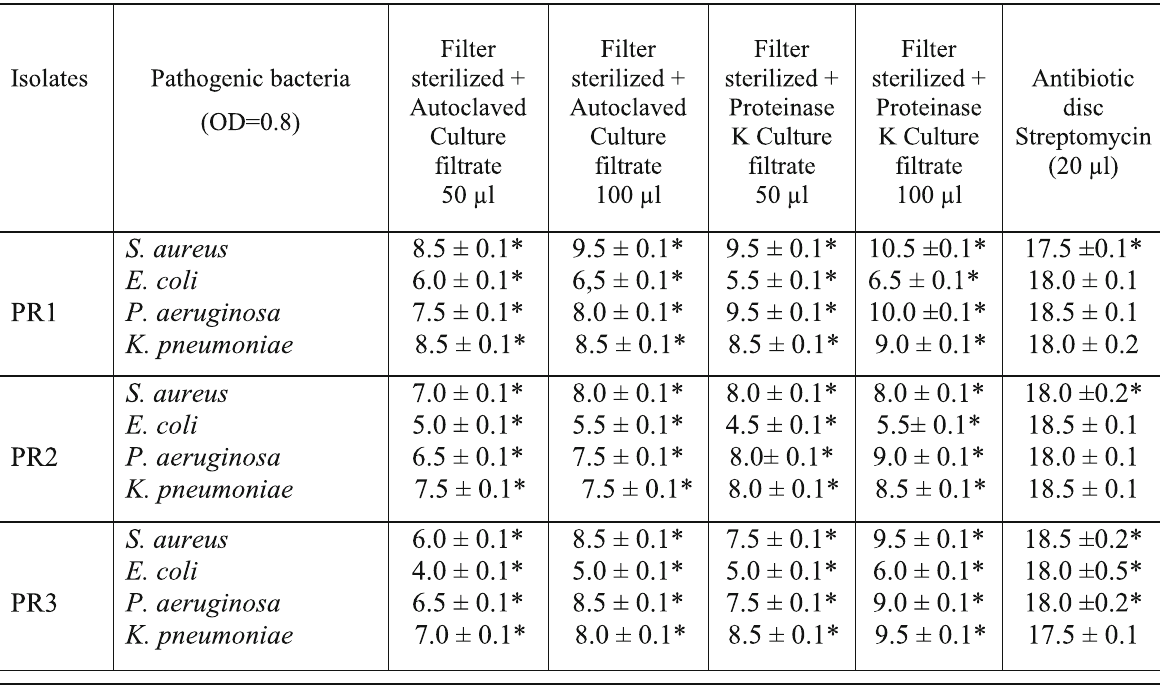
Table 4 Antibacterial activity of culture filtrate of PR1, PR2, and PR3 against pathogenic